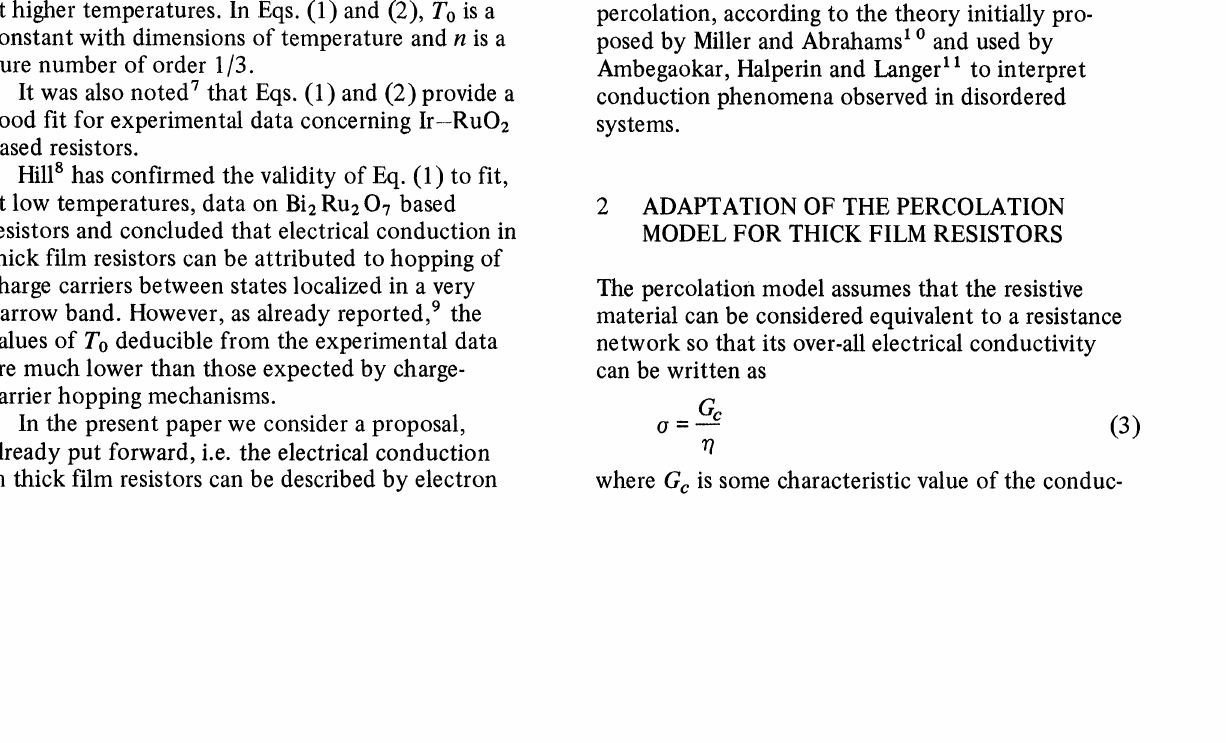
’oo zoo :zoo 400 (* K) FIGURE 1 Normalized conductivity of a typical thick-film resistor vs.